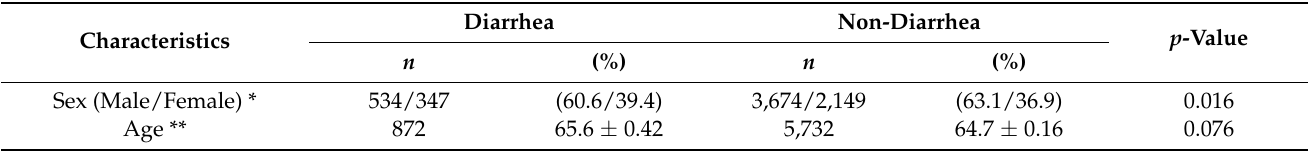
Table 1. Characteristics of patients with or without diarrhea.